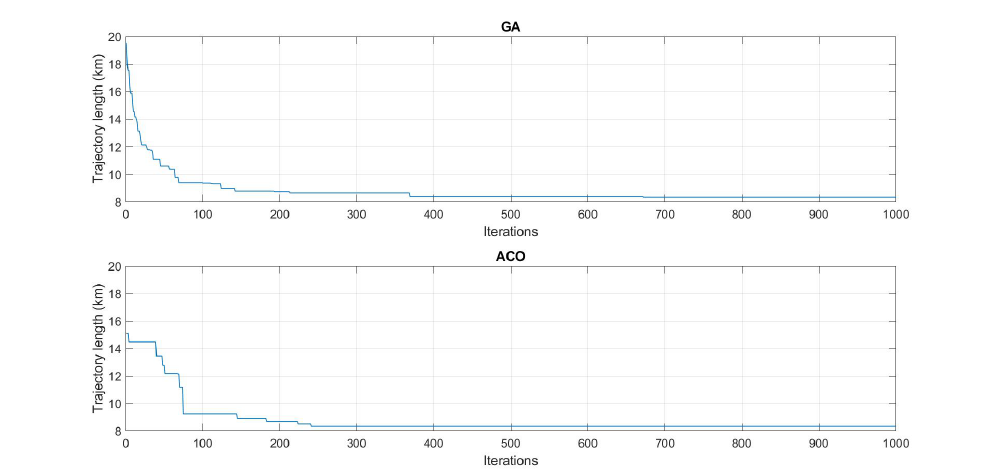
Figure 19. After 1000 iterations, GA found a trajectory of 8324 m (left figure) and ACO a trajectory of 8326 m (right figure). The parameters for ACO were 50 ants, α = β = 1 (weights) and ρ = 0.05 (evaporation). The differences between the trajectories are located near the nodes 4, 6, and 3.